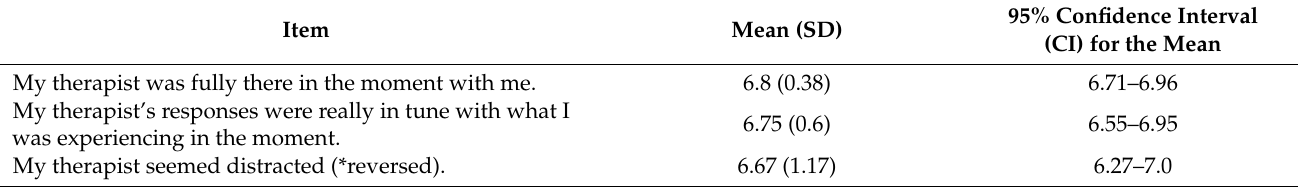
95% Confidence Interval (CI) for the Mean